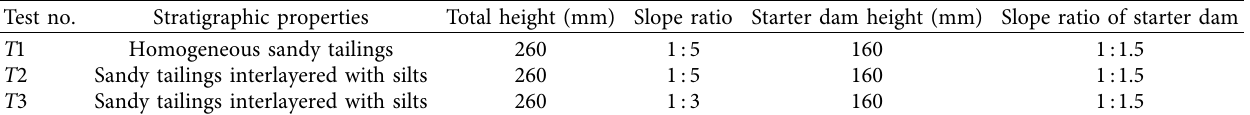
Table 3: Summary of the centrifuge shaking table tests carried out at 40g. Test